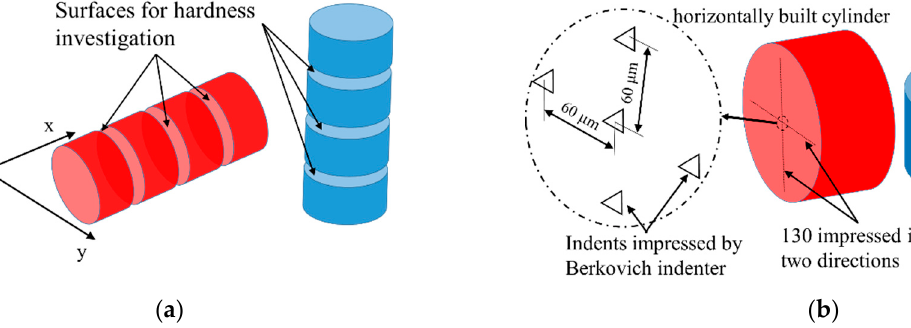
Figure 3. ( a ) sectioning plan for hardness measurement of L-PBF fabricated vertical and horizontal samples, ( b ) nano-indentation maps for sectioned discs from vertical and horizontal samples.